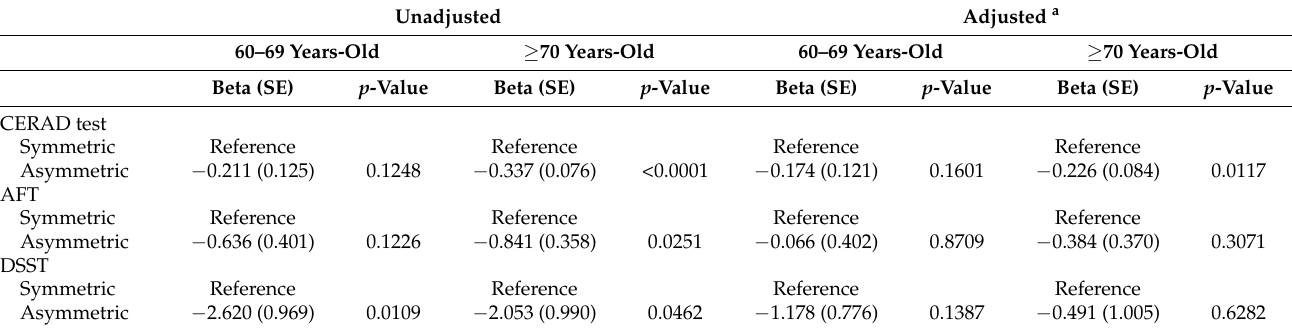
Table 4. Beta coefficients (SE) for HGS asymmetry in age groups by cognitive function